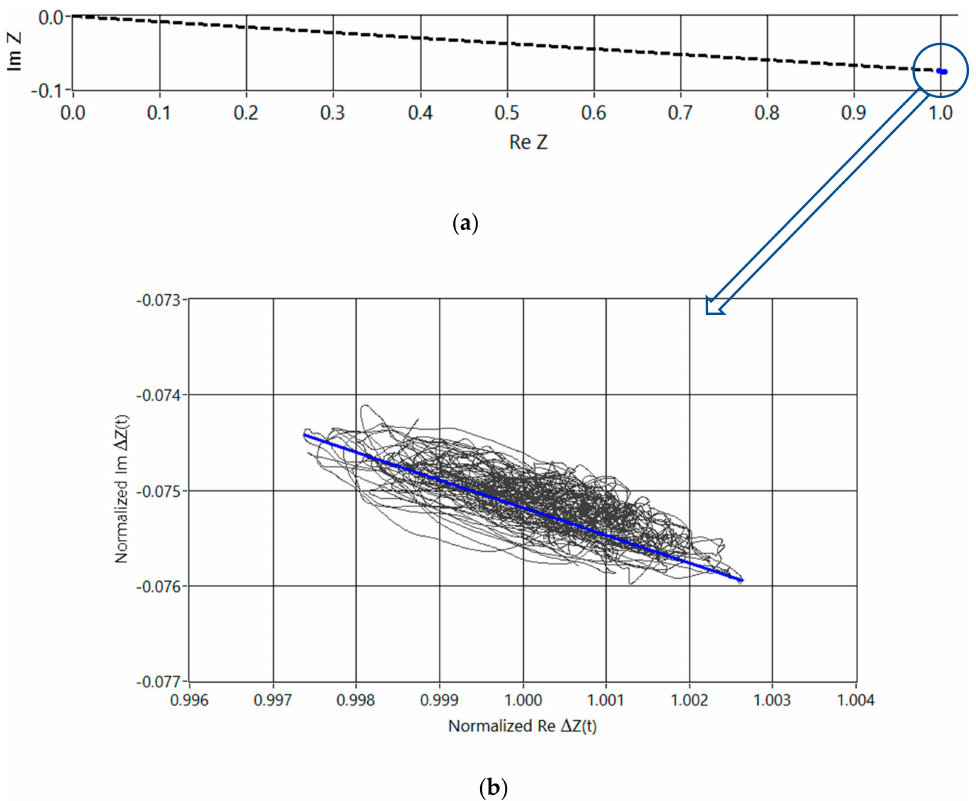
Figure 3. Normalized Nyquist plot of the impedance on the radial artery during several cardiac cycles. Real and imaginary parts of the base vector (dashed line, see ( a )) together with modulation (blue dot at the end of the vector), and a zoomed-out modulation around the top of the base vector with average blue line ( b